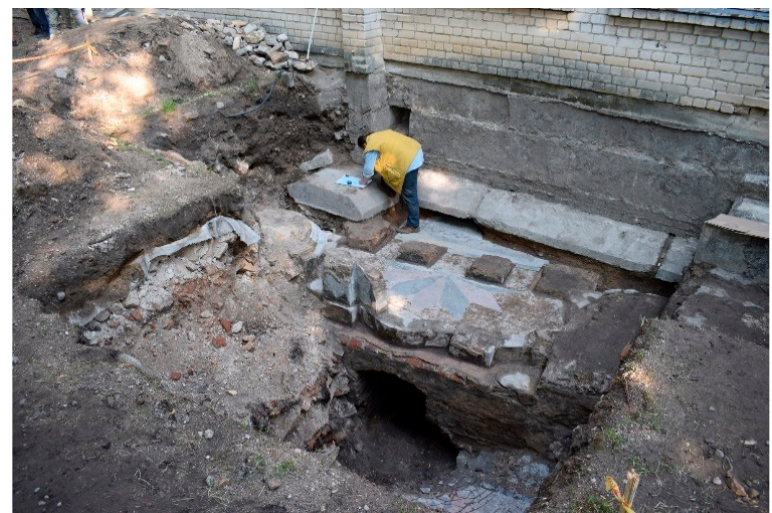
Figure 7. The excavation of the bimah . Photo: Jon Seligman, Israel Antiquities Authority.